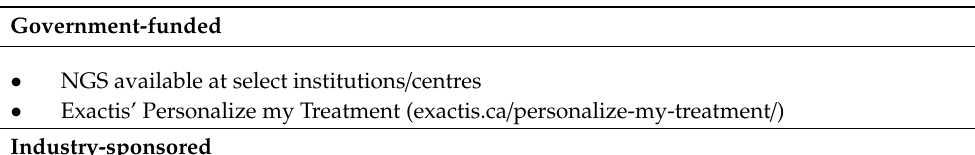
Table 1. NTRK gene fusions testing options in